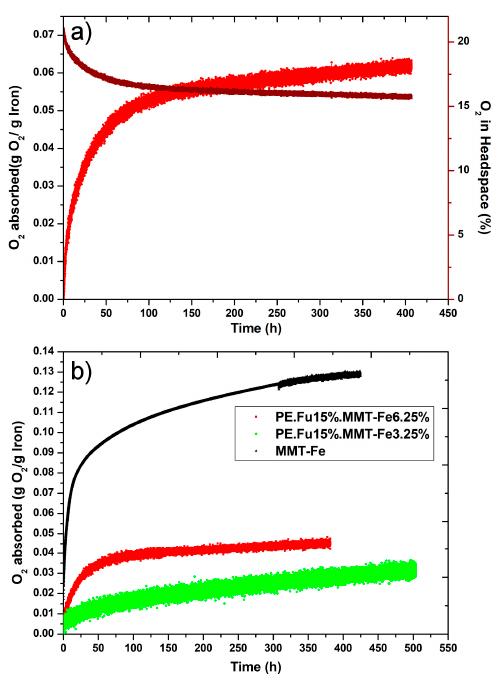
Figure 6. ( a ) Example of experimental O 2 –headspace depletion curves and corresponding O 2 adsorption curves for LLDPE.Fu15.MMT-Fe6.25 and ( b ) comparison of oxygen adsorption of dried MMT-Fe powder, LLDPE.Fu15.MMT-Fe3.75, and LLDPE.Fu15.MMT-Fe6.25 films.